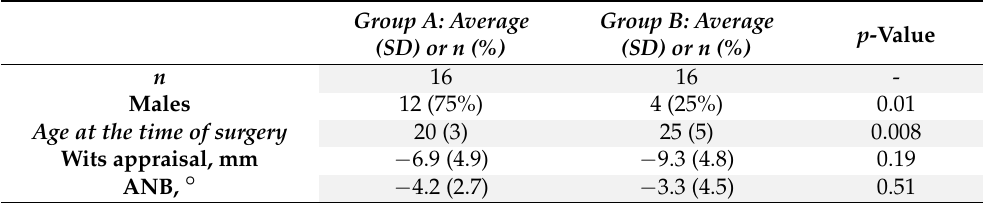
Table 1. Distribution of the sample based on the average age at the time of surgery, sex, and initial cephalometric values.